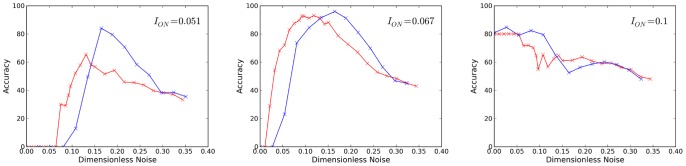
Accuracy  of the AND/NAND logic response for simulations (red) and circuit measurements (blue) as a function of noise strength  and encoding amplitude .Noise strength  for the circuit measurements has been converted to dimensionless strength  using Eq. (10) with .